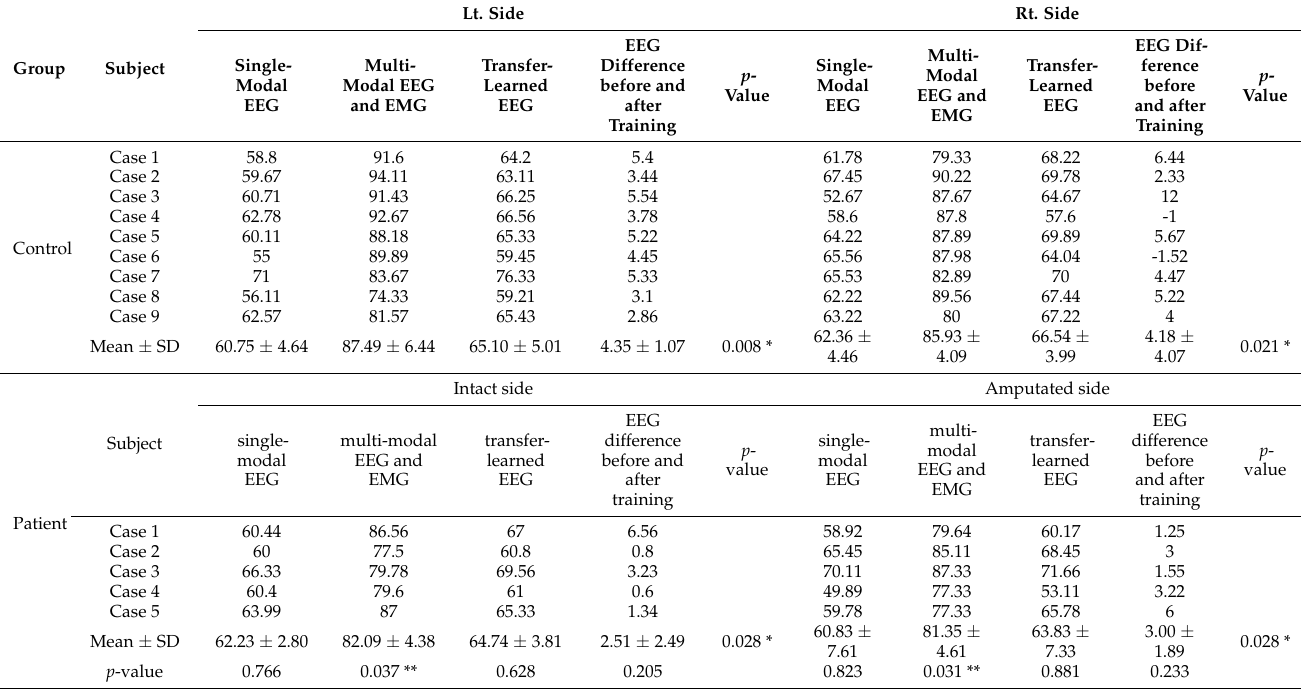
Table 1. Average classification accuracy [%] of single-modal EEG, multi-modal EEG and EMG, and transfer-learned EEG of each subject in control and patient groups.